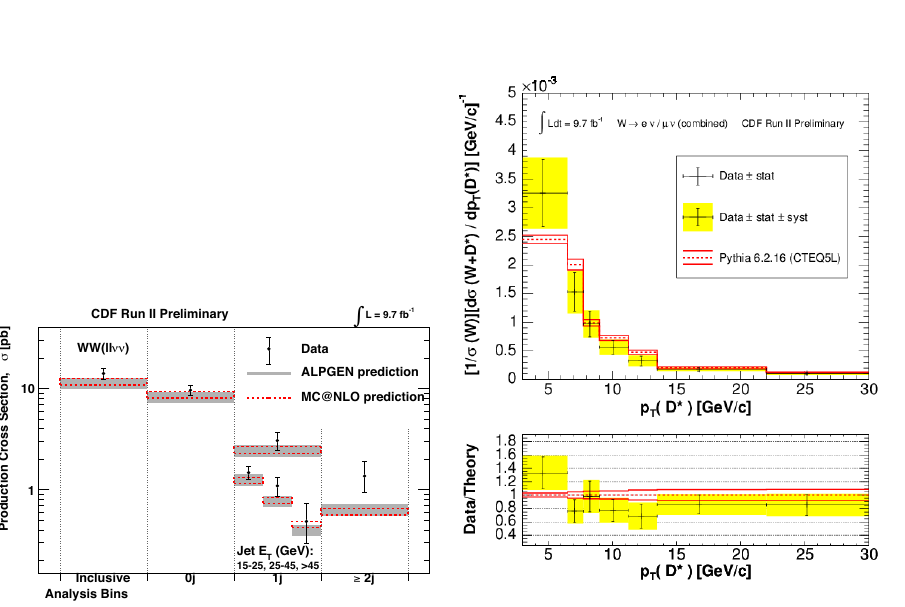
Figure 7. Cross section measurements of standard model processes involving W boson production at CDF.